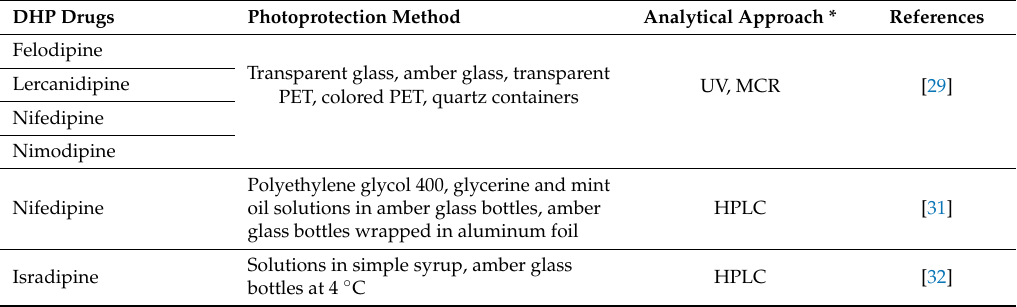
Table 1. Use of dark or opaque containers. MCR: multivariate curve